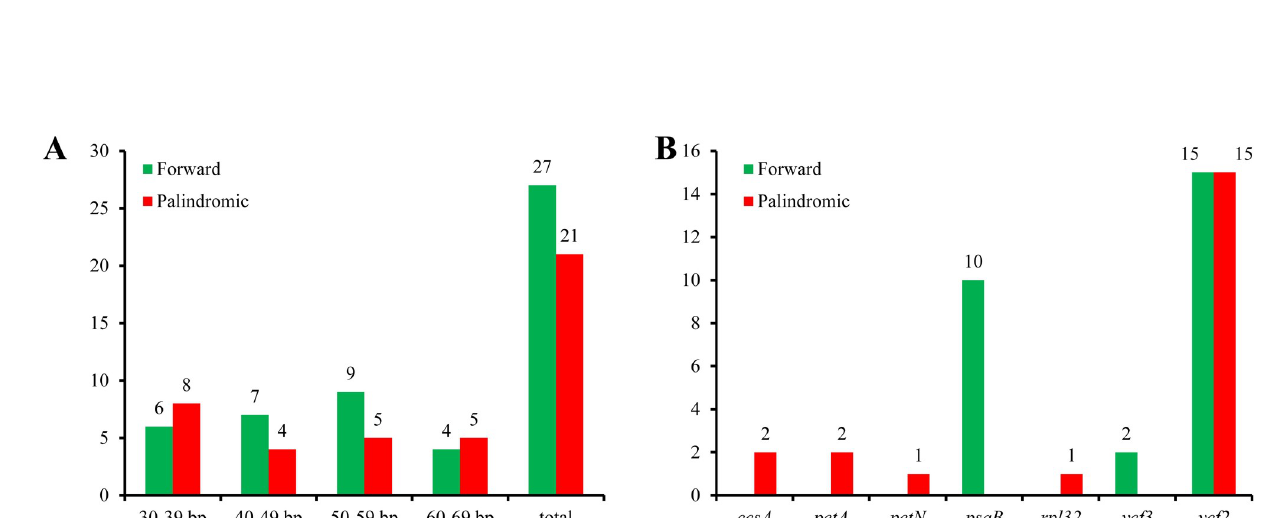
Fig 2. Distribution of repeat sequences in H . cordata cp genome. A, Number of forward and palindromic types of repeats with different size in length; B, Number of repeats within seven